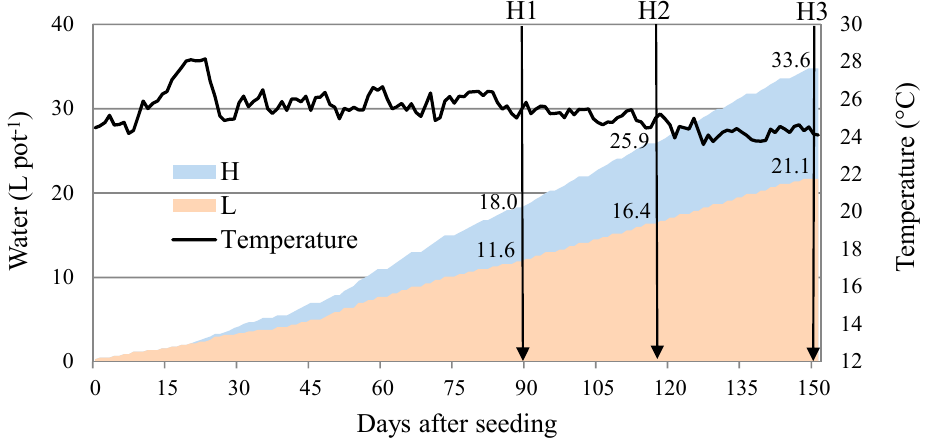
Figure 1. Cumulative amount of water (L·pot − 1 ) supplied during the experiment under low (L) (light gray) and high (H) (dark gray) soil moisture. Average daily temperature in the greenhouse (°C) (solid line) is also displayed. H1, H2, and H3 indicate the three harvests. Numbers indicate the amounts of water supplied.